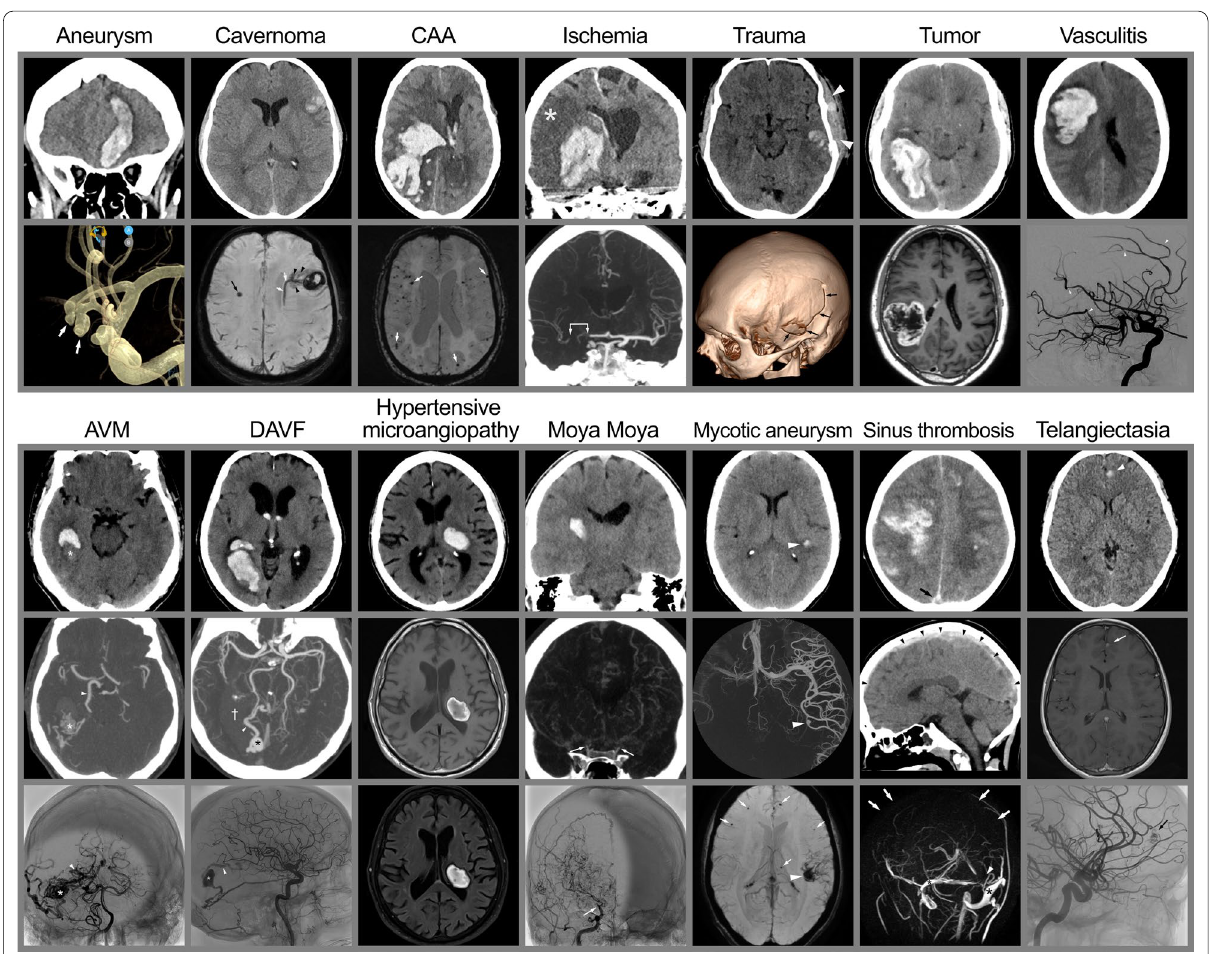
Fig. 3 Etiology. The figure illustrates the most common etiologies of ICH. Top row: Aneurysm —Bleeding from cerebral aneurysms may rarely present predominantly as ICH (top panel), such as this case of a bi-lobulated anterior communicating artery aneurysm (white arrows in CBCT 3D reconstruction in the bottom panel). Cavernoma —Bleeding in a cavernoma in the left hemisphere (top panel) with an associated DVA (black arrowheads and white arrows for the draining vein) and another cavernoma (black arrow) in the contralateral hemisphere on MRI (SWI). CAA (Cerebral Amyloid Angiopathy) —with a large parietal lobar ICH with the typical “finger-like projections” (top panel) and multiple amyloid deposits throughout the brain on a preceding MRI (SWAN, bottom panel). Ischemia —Illustrating an ICH an association with an acute ischemic stroke (top panel) caused by an embolic occlusion of the terminal internal carotid artery (T-occlusion—indicated by the white arrows in the CTA in the lower panel). Trauma —A common cause of ICH, illustrated by a temporal ICH in the left hemisphere, associated with an extracranial hematoma (white arrowheads in the top panel) and a skull fracture (black arrows in the 3D reconstruction in the bottom panel). Tumor —A large ICH in the right hemisphere with an underlying glioma, visualized on a subsequent MRI (T1-TSE with Gadolinium in the bottom panel). Vasculitis —A large frontal ICH associated with CNS vasculitis with several stenosed intracranial arteries (examples indicated by white arrowheads in the sagittal DSA in the bottom panel). Bottom row: AVM (ArterioVenous Malformation) —A temporal ICH where the AVM nidus (asterisk in all 3 panels) is protruding into the hematoma. The main feeder is indicated by white arrowheads (middle panel CTA and bottom panel DSA). DAVF (Dural ArterioVenous Fistula) – ICH with intraventricular extension adjacent to a DAVF (hematoma indicated by † in the CTA; middle panel) with an ectasia (asterisks in the middle and bottom panels) on a large draining vein (white arrowheads in the middle and bottom panels). Hypertensive microangiopathy —Typical location in the basal ganglia as this example with an ICH in the left thalamus, shown on CT (top panel) and MRI (T1 TSE in the middle panel and T2 FLARI in the bottom panel). Moya Moya —ICH caused by increased demand from thalamostriatal collateral vessels due to stenosis/occlusion of the distal internal carotid arteries (white arrows in the CTA in the middle panel and DSA in the lower panel). It is the collateral network of numerous small vessels that give rise to the typical “puff of smoke” appearance in advanced stages. Mycotic aneurysm —illustrated by a small ICH indicated by white arrowheads on CT (top panel) and MRI (SWI in the bottom panel) from a mycotic aneurysm on a distal MCA branch (white arrowhead in the CBCT angiography in middle panel) caused by septal emboli from staphylococcal endocarditis. Additional septic emboli seen on MRI are indicated by white arrows (SWI in the bottom panel). Sinus thrombosis —Illustrated by bilateral ICH in a case with extensive thrombosis of the superior sagittal sinus. The hyperdense appearance on NCCT (black arrowheads) is illustrated in the middle panel and the absence of superior sagittal sinus (white arrows on MR venography, bottom panel) and the torcula (white arrowhead in the bottom panel). Telangiectasia —Illustrated by an Ossler patient with a small frontal ICH where MR shows gadolinium enhancement in the lesion (white arrow in the middle panel; MR T1 TSE with Gadolinium) corresponding to a small telangiectasia without shunting on DSA (black arrow in bottom